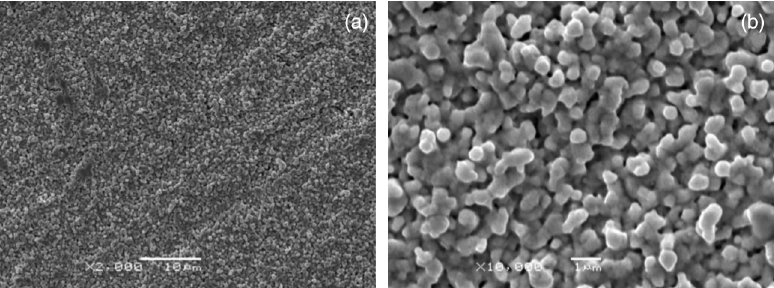
FIG. 2. SEM micrographs of a Pb film deposited on Nb, with energy density 0 : 09 J = cm 2 , pulse duration of 0.5 ps, and a wavelength of 248 nm: (a) low magnification; (b) high